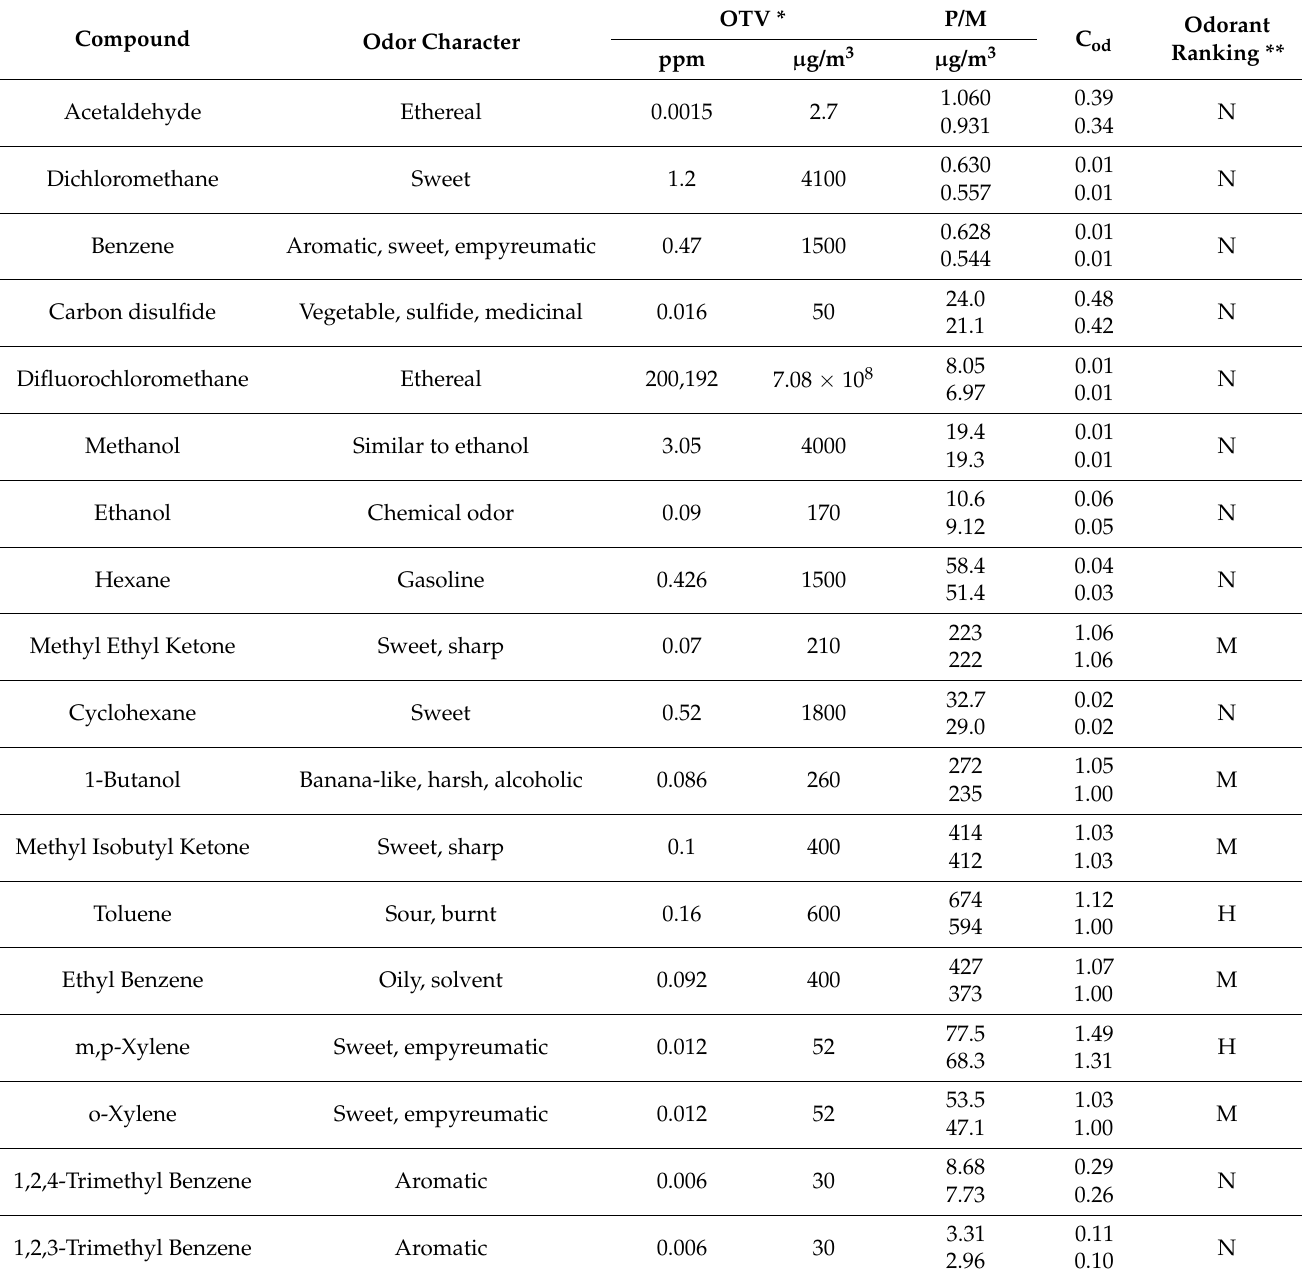
Table 3. Odor threshold of the potential VOC substances and calculated prediction results with the odor equation at top 2 maximum ground level in the domain